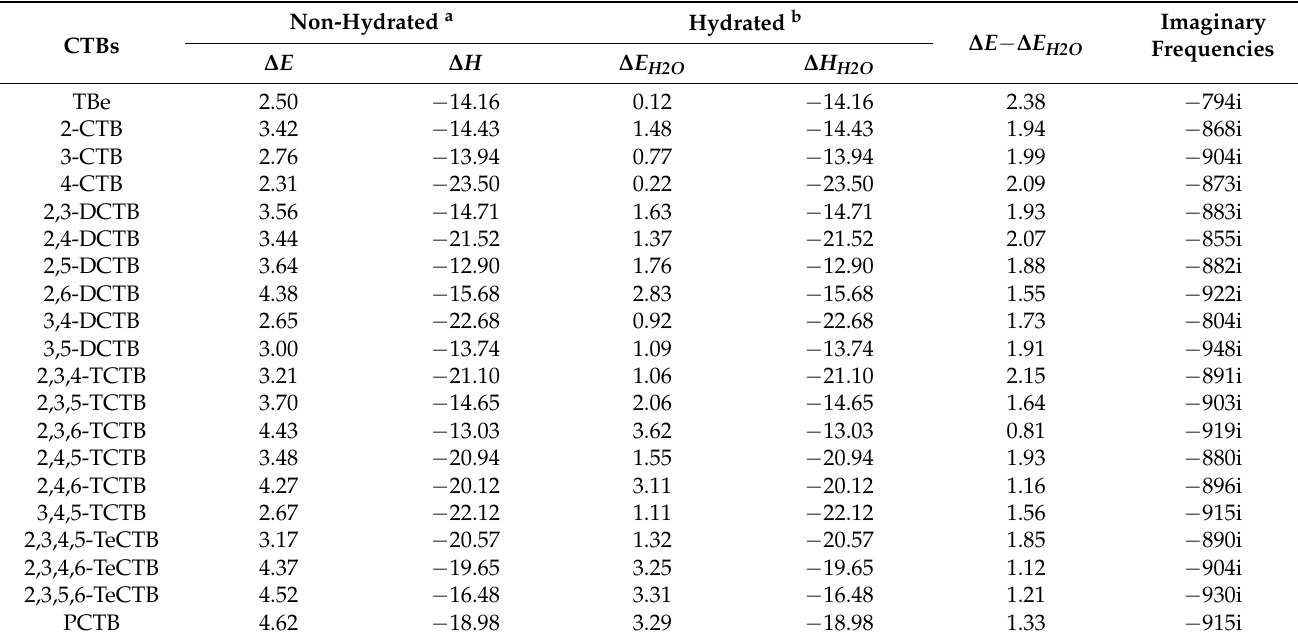
Table 2. Imaginary frequencies (in cm − 1 ) in transition states, potential barriers ∆ E (in kcal mol − 1 ), and reaction heats ∆ H (in kcal mol − 1 , 0 K) of the H abstraction of CTBs by H atom in hydrated and non-hydrated cases, respectively. ∆ E and ∆ H are calculated at 0